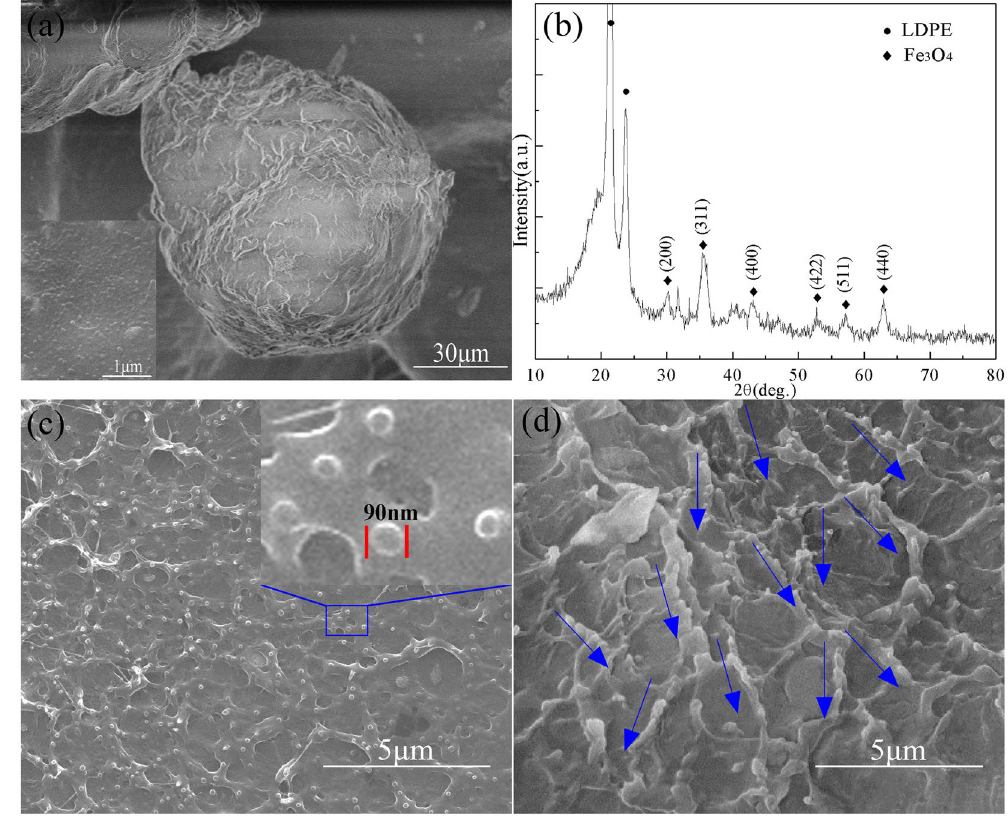
Figure 1. ( a ) SEM images of the Fe 3 O 4 -LDPE particles. The inset shows the partial SEM image of the Fe 3 O 4 - LDPE particles. ( b ) XRD pattern of the Fe 3 O 4 /LDPE composites at 7 vol.% concentration. ( c ) Cross-sectional SEM images of the Fe 3 O 4 /LDPE composites at 7 vol.% concentration. The inset shows the partial SEM image of the Fe